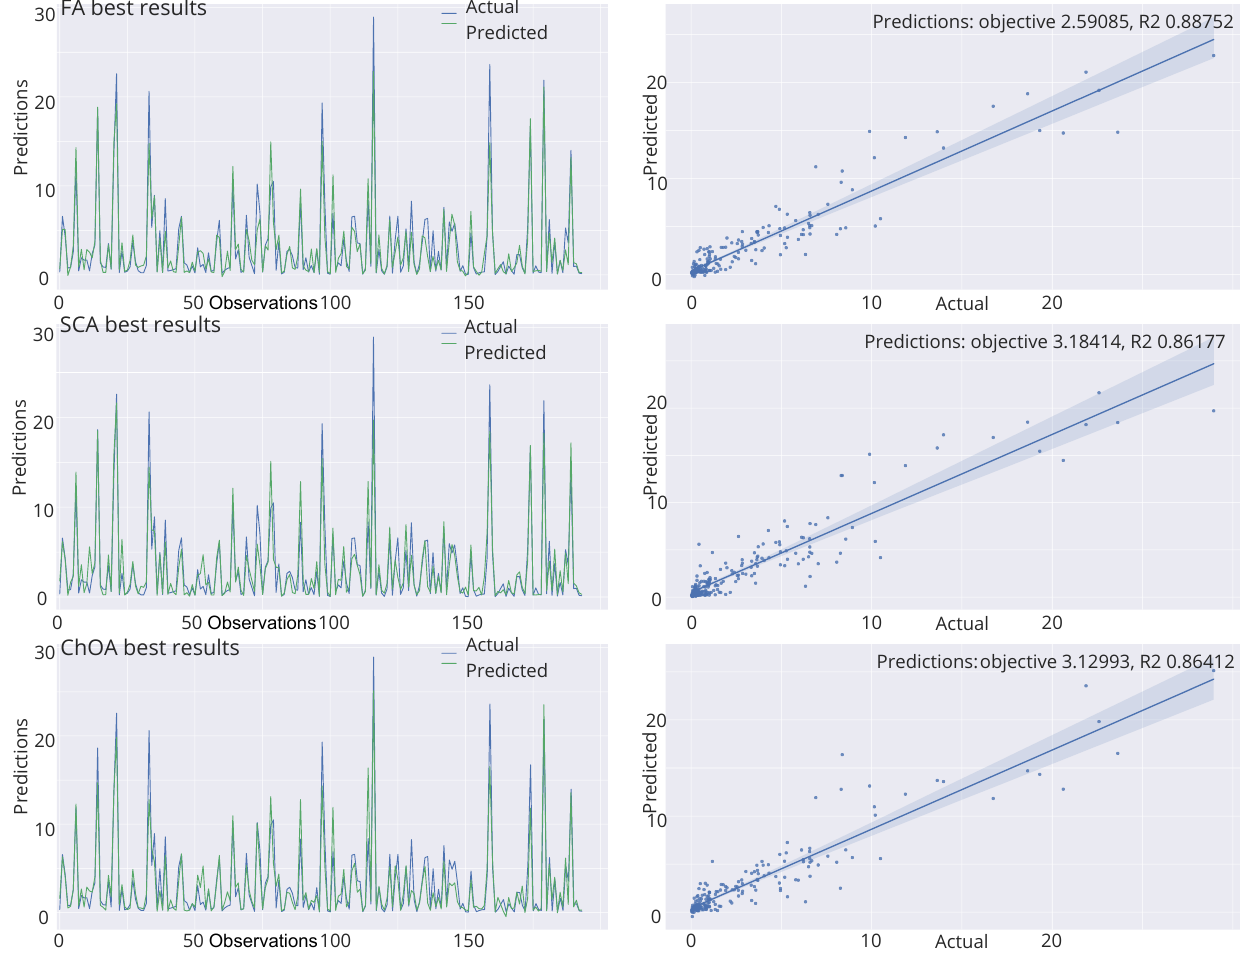
Figure 6. Best-predicted outcomes by the best produced models of HSA-SCA, FA, SCA and ChOA